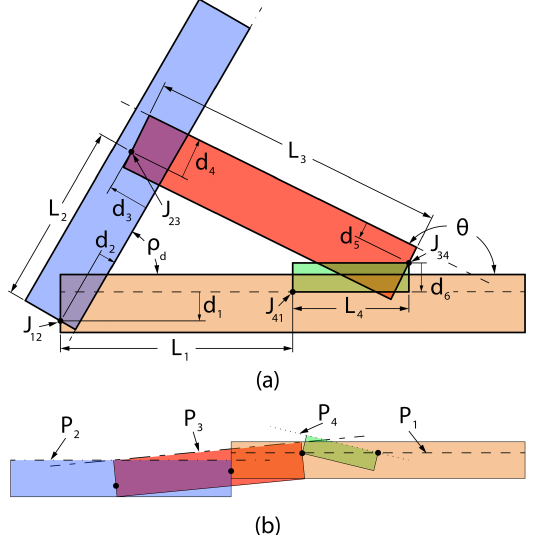
Figure 2. General diagram for a planar deploying strut ThUDS with key parameters shown. Showing side views in the (a) deployed and (b) flat states. Dashed lines designate joint reference planes. Joint offset ( d ) arrows denote the parameter’s ( P ) positive direction.